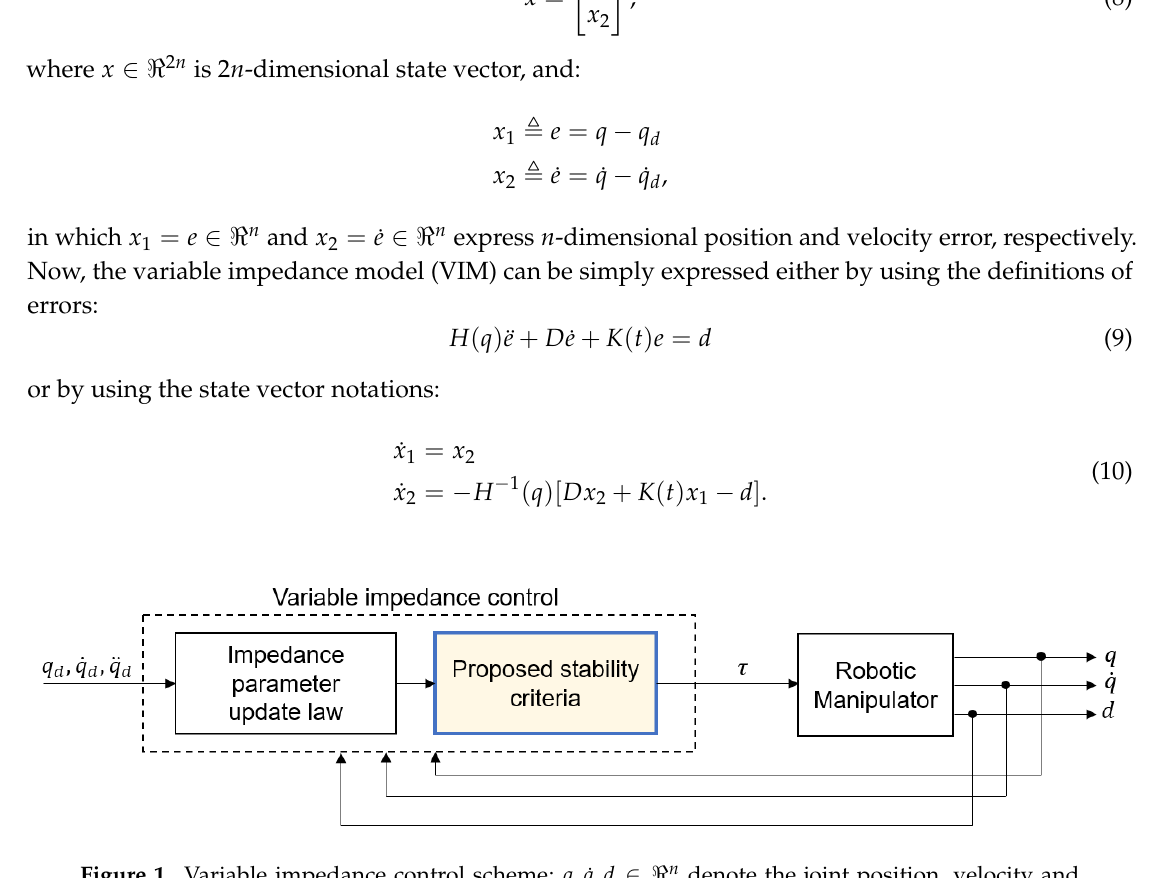
Figure 1. Variable impedance control scheme; q , ˙ q , d ∈ (cid:60) n denote the joint position, velocity and the externally applied joint force/torque, respectively, and q d , ˙ q d , ¨ q d ∈ (cid:60) n the desired joint position, velocity and acceleration, respectively, and τ ∈ (cid:60) n the control